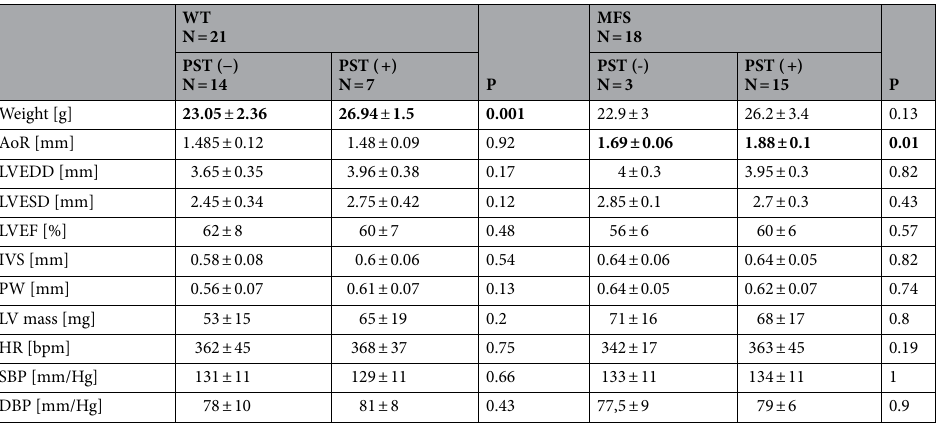
Table 3. Left ventricular and aortic remodeling in the 4 mo-age mice according to the presence of PST. AoR aortic root diameter, LVEDD left ventricular end-diastolic diameter, LVESD left ventricular end-systolic diameter, LVEF left ventricular ejection fraction, IVS interventricular septum thickness, PW posterior wall thickness, HR heart rate, SBP systolic blood pressure, DBP diastolic blood pressure. Data is presented as mean ± SD. Independent two-sample t-test for normally distributed variables and the Mann–Whitney U test for non-parametric distribution. SP<0.05, in bold, denote statistical significance.